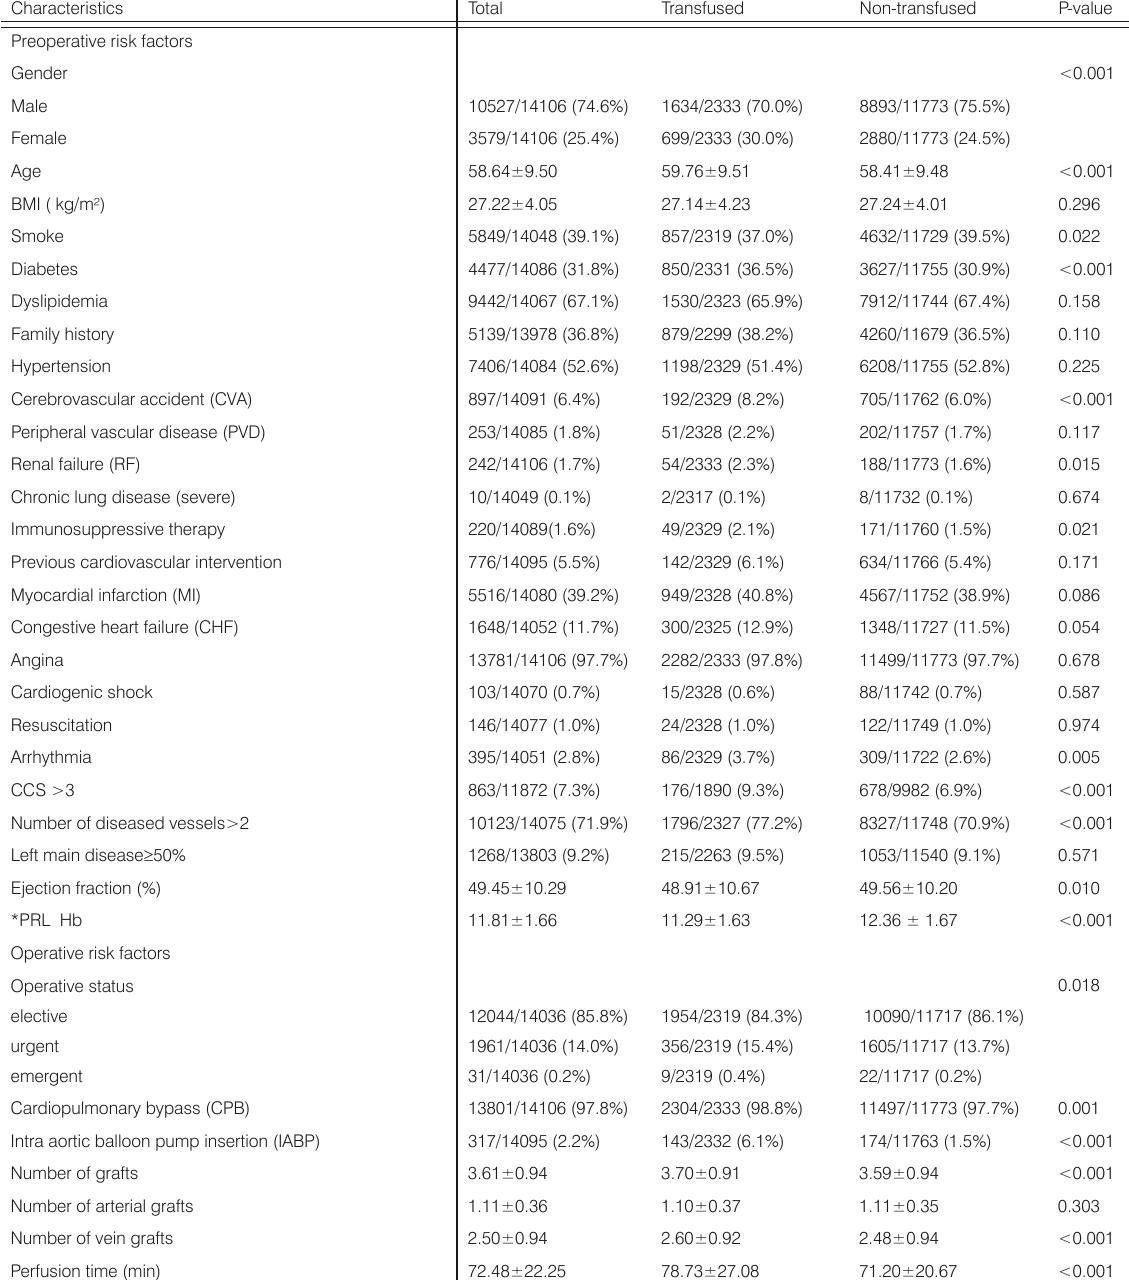
Table 1. Demographic, preoperative and operative characteristics of patients underwent isolated